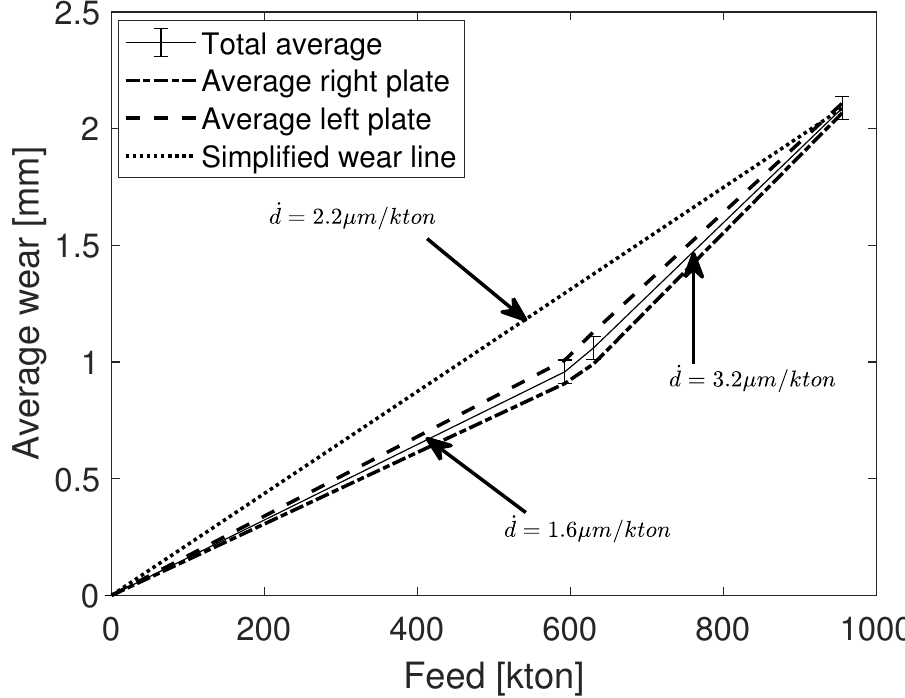
Figure 11. Plots showing the experimentally average wear depth for the plates described in Figure 3 as a function of the material feed passing the plates. The error bar represents the estimated error range from wear thickness measurements. ˙ d is the wear rate between the different